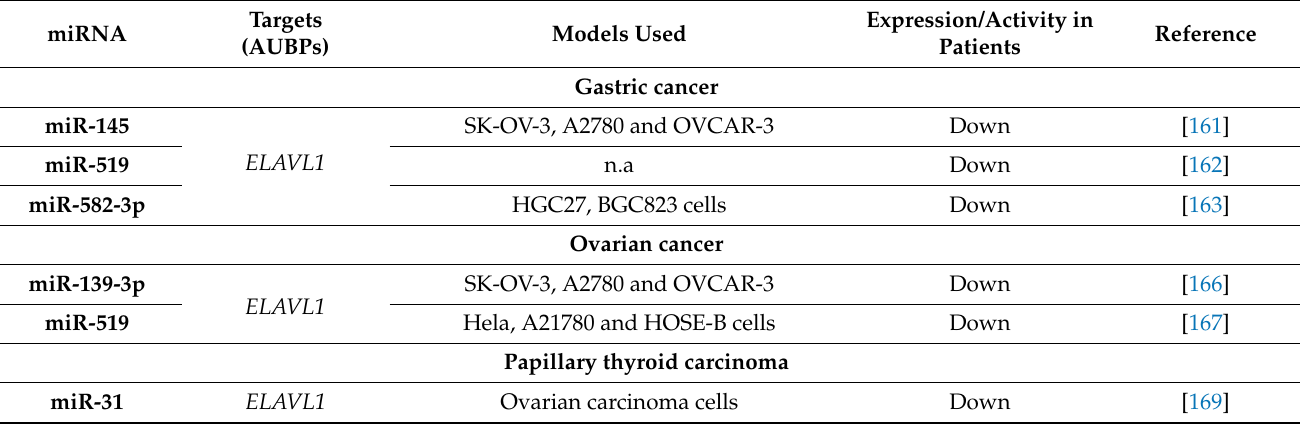
Table 1. MiRNAs regulating HuR and TTP family members and involved in cancers. n.a: not